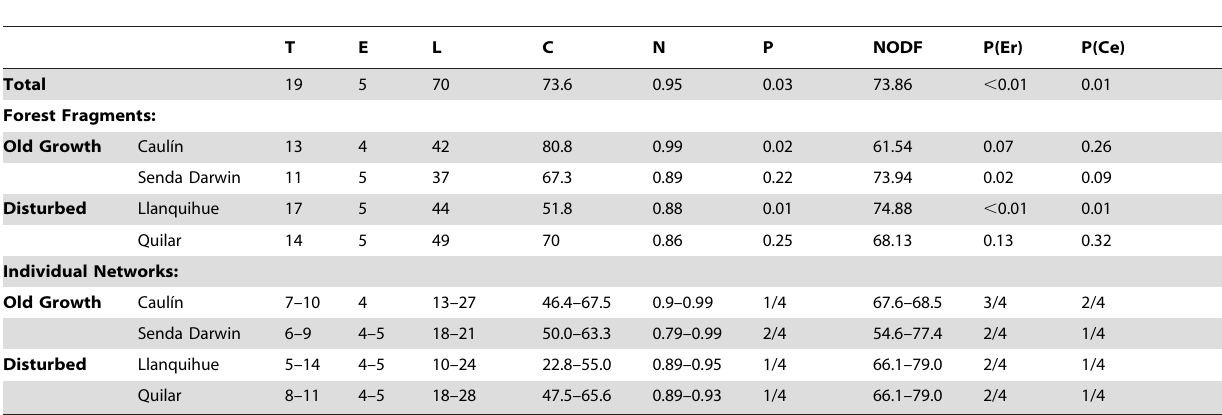
Table 1. Network properties of 16 epiphyte-tree networks measured in old-growth and disturbed forest fragments (four forest fragments, four sites per